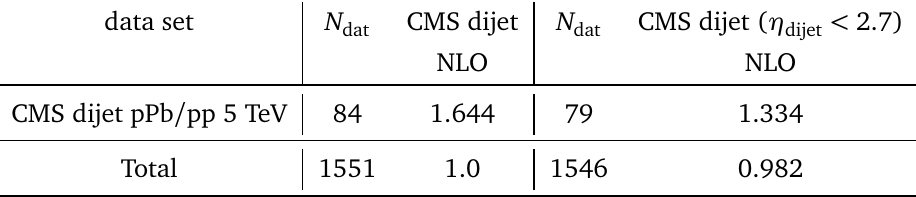
> 2.7 in all bins of dijet